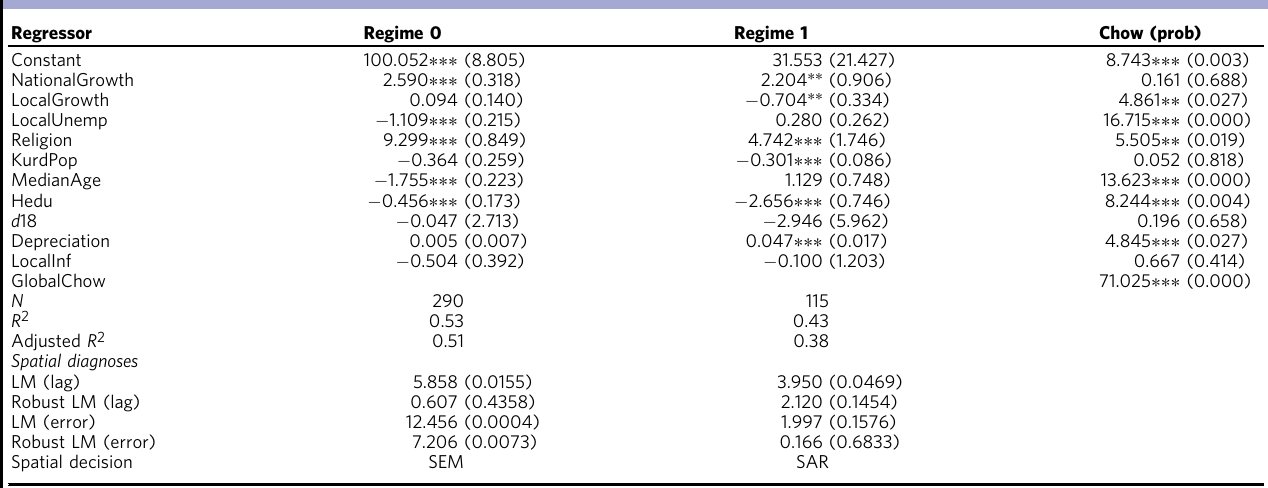
Table 3 Spatial regime results for the AKP.